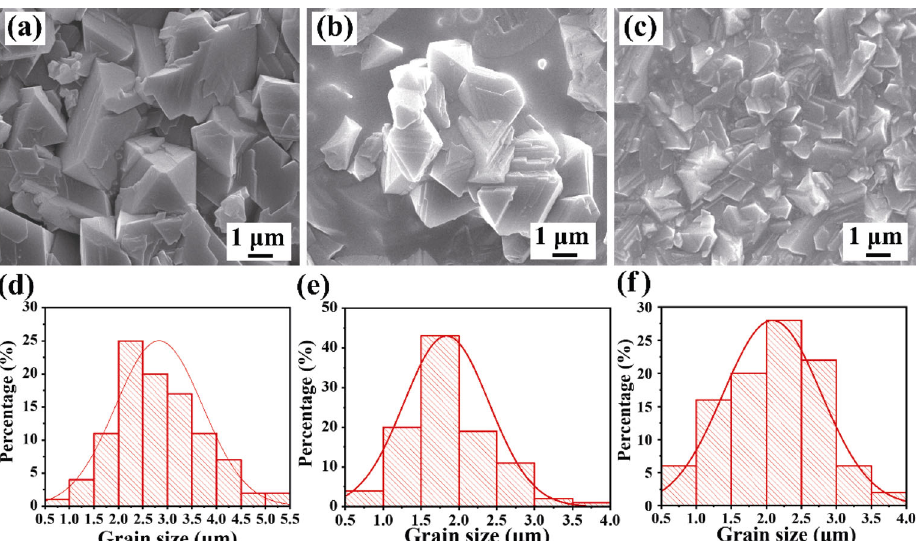
Fig. 4 SEM images and average grain sizes of (a, d) (Mg 0.2 Mn 0.2 Fe 0.2 Co 0.2 Ni 0.2 )Fe 2 O 4 , (b, e) (Mg 0.2 Fe 0.2 Co 0.2 Ni 0.2 Cu 0.2 )Fe 2 O 4 , and (c, f) (Mg 0.2 Fe 0.2 Co 0.2 Ni 0.2 Zn 0.2 )Fe 2 O 4 . Ideally, in a spinel structure, Fe 3+ forms [FeO 6 ] octahedron with the nearest six O 2 − , and M 2+ forms [MO 4 ] tetrahedron with the nearest four O 2 − . Since the [FeO 6 ] octahedron and [MO 4 ] tetrahedron overlap